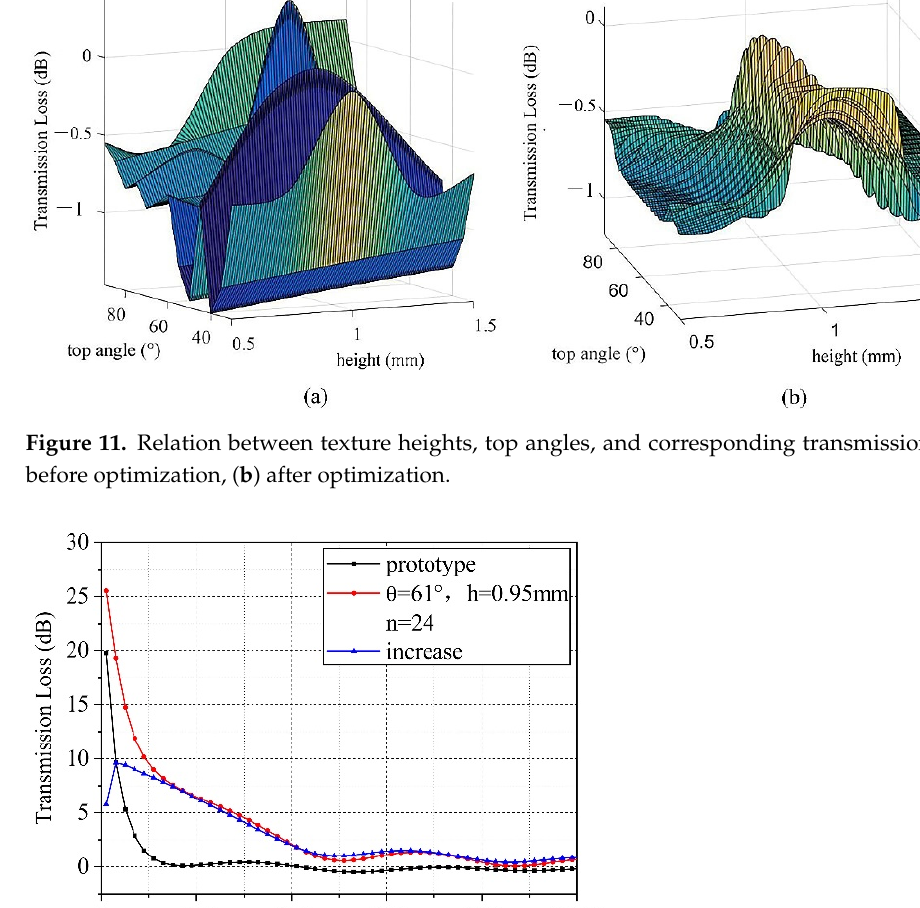
Figure 12. Comparison between prototype and optimized bionic exhaust tailpipe transmission loss curves.